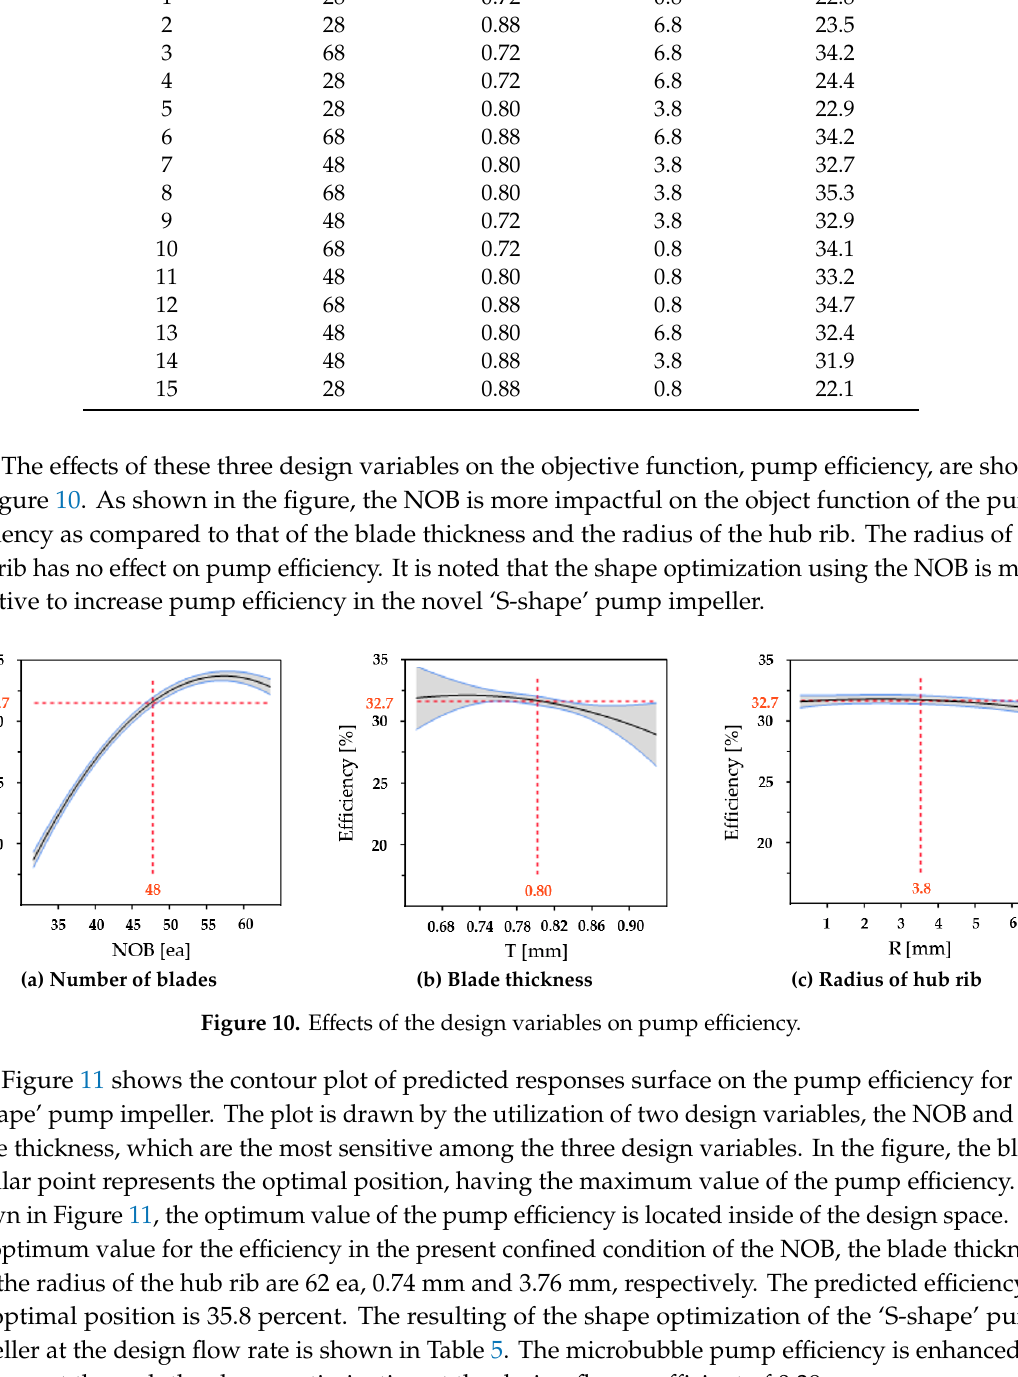
Table 4. Pump efficiency obtained by RSM.